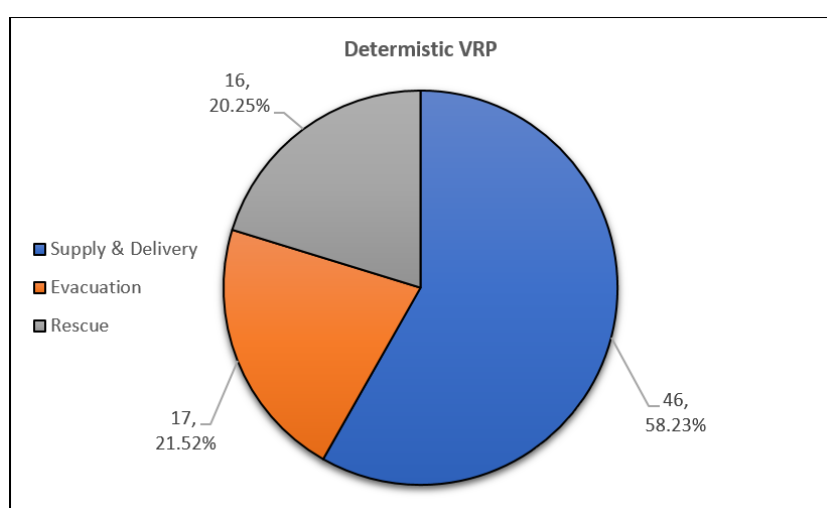
Figure 23. Selected Humanitarian Operation based on Deterministic